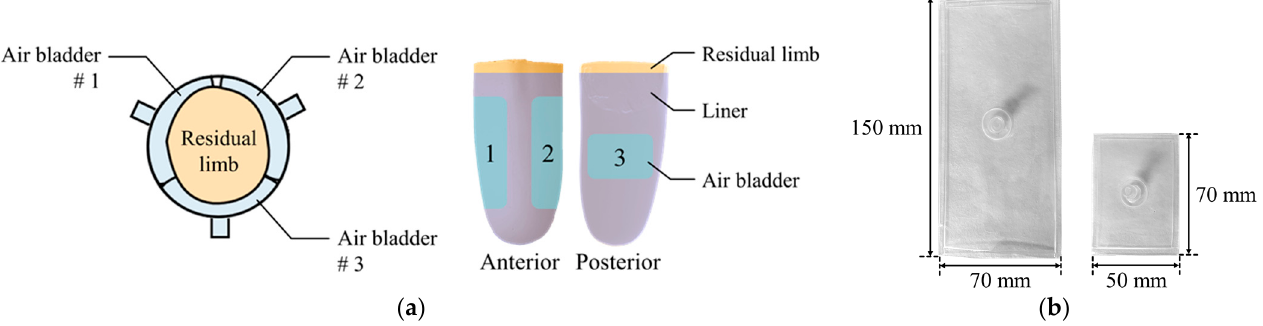
Figure 4. ( a ) The locations of the air bladders in the prosthetic socket; ( b ) the appearance of the air bladders.